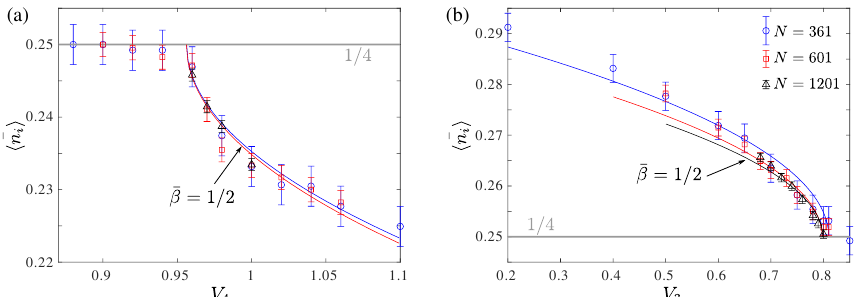
(a) along the 3,4 = V . Solid lines are results 4 3 as a fitting parameter and Pokrovsky- 3